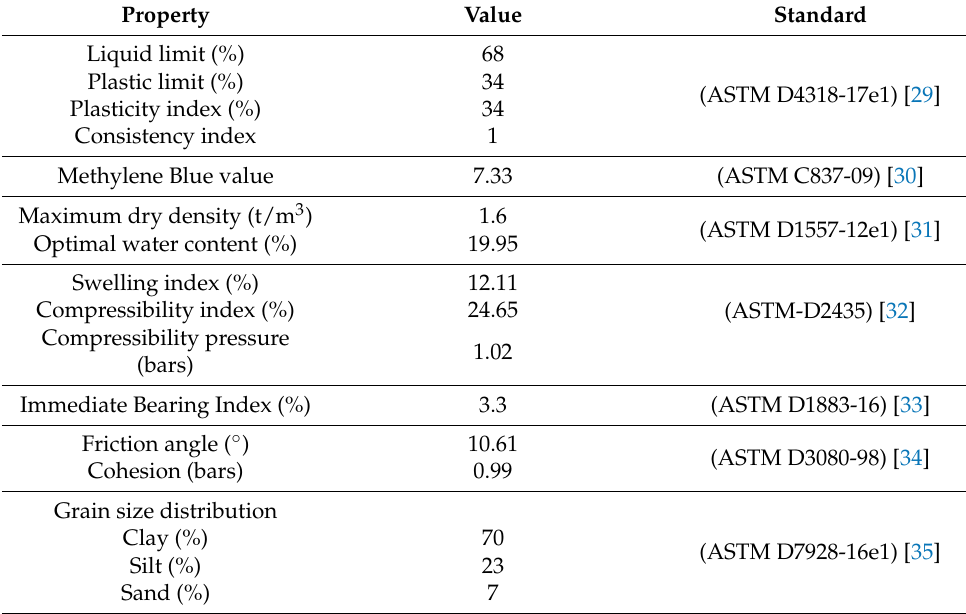
Table 2. Engineering properties of the soil – bentonite mixture.